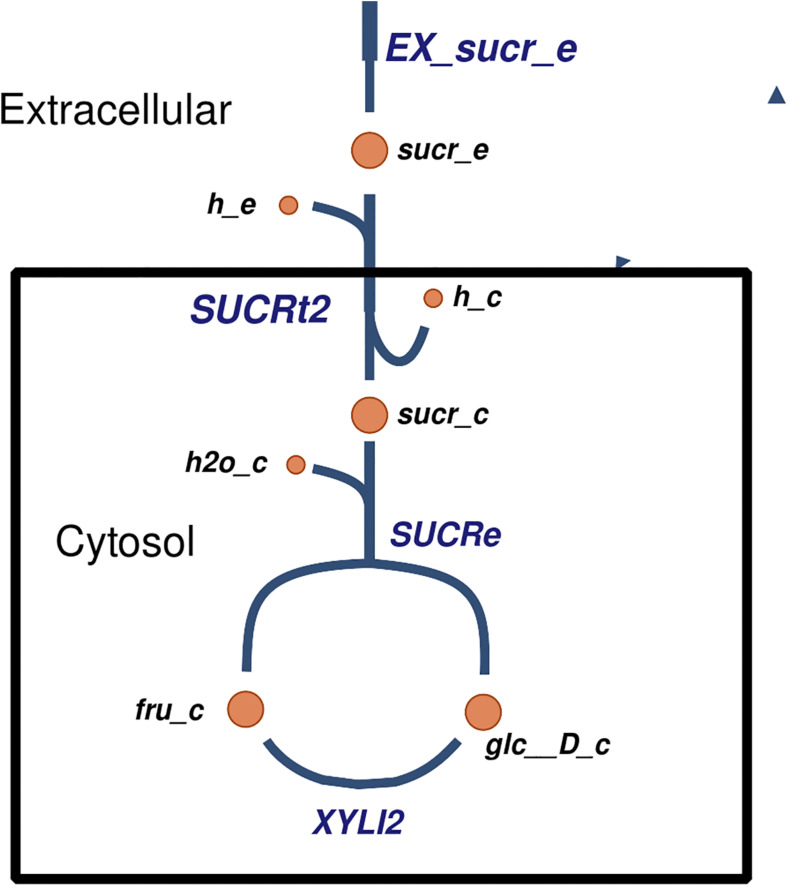
The proposed mechanism of transport of sucrose in Xpm. Sucrose is transported into the cell, where it is degraded into fructose and glucose. Constructed in Escher (King et al., 2015).